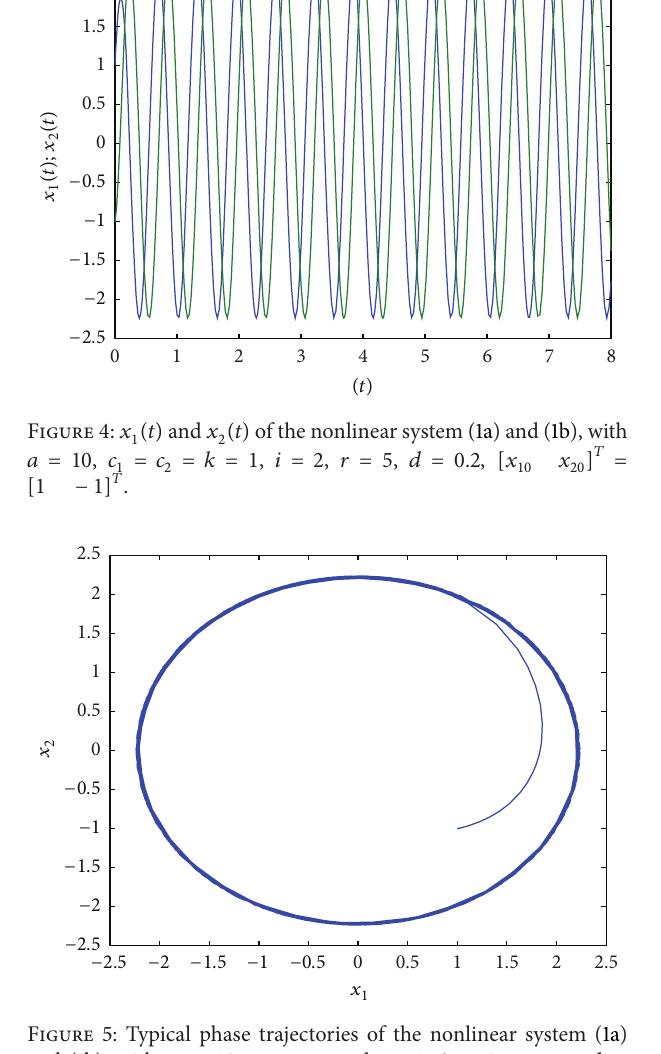
Figure 5: Typical phase trajectories of the nonlinear system (1a) and (1b), with 𝑎 = 10, 𝑐 1 = 𝑐 2 = 𝑘 = 1, 𝑖 = 2, 𝑟 = 5, 𝑑 = 𝑥 ] 𝑇 = [1 − 1] 𝑇 0.2, [𝑥 10 20